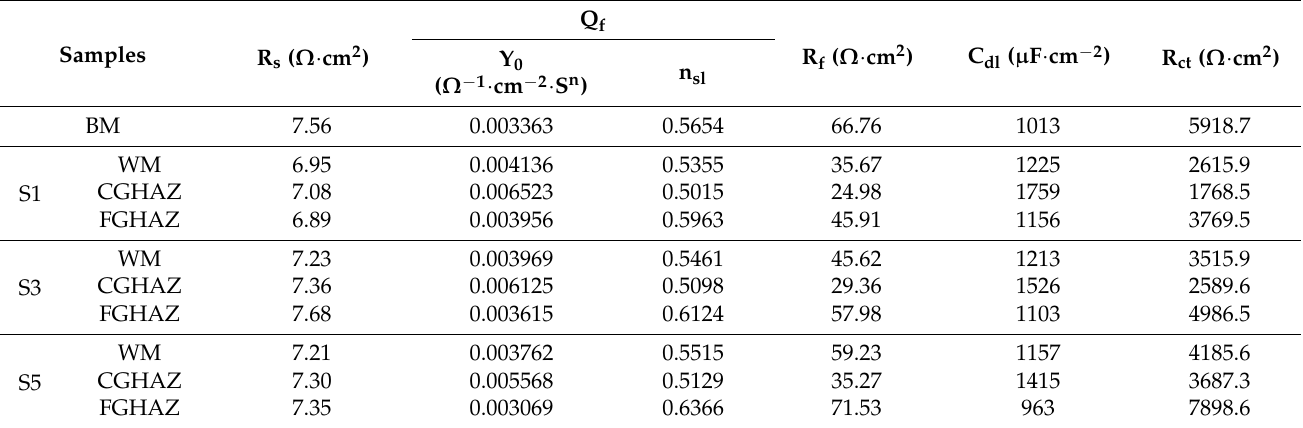
Table 5. The fitted values of EIS for different samples under immersion for 96